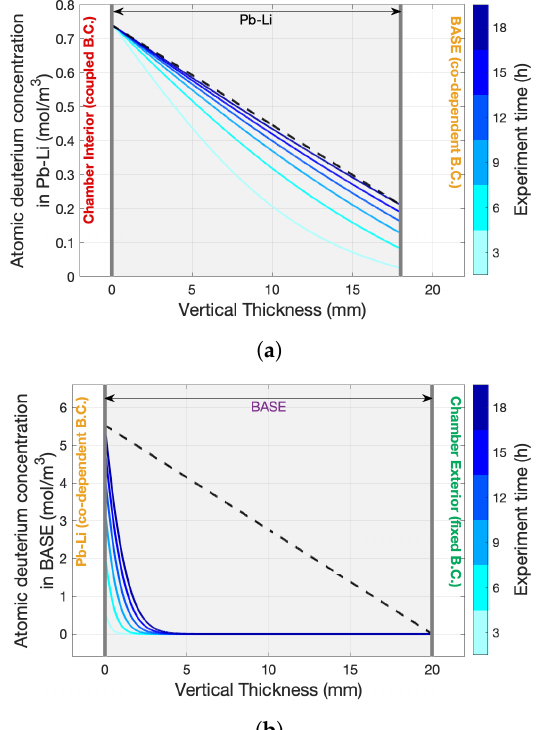
Figure 11. Simulation of concentration profiles evolution during 18 h in Pb-Li and BASE steel media, using avg dissolution parameters ( vide Tables 1 and 3). Initial gas pressure set at 780 mbar, heater temperature set at 450 ◦ C. ( a ) Concentration profile evolution in Pb-Li. Concentration maximum in the order of 8 × 10 − 1 mol/m 3 . Medium thickness of 18mm. ( b ) Concentration profile evolution in BASE. Concentration maximum in the order of 5mol/m 3 . Notice the difference in concentration scale in comparison to Figure